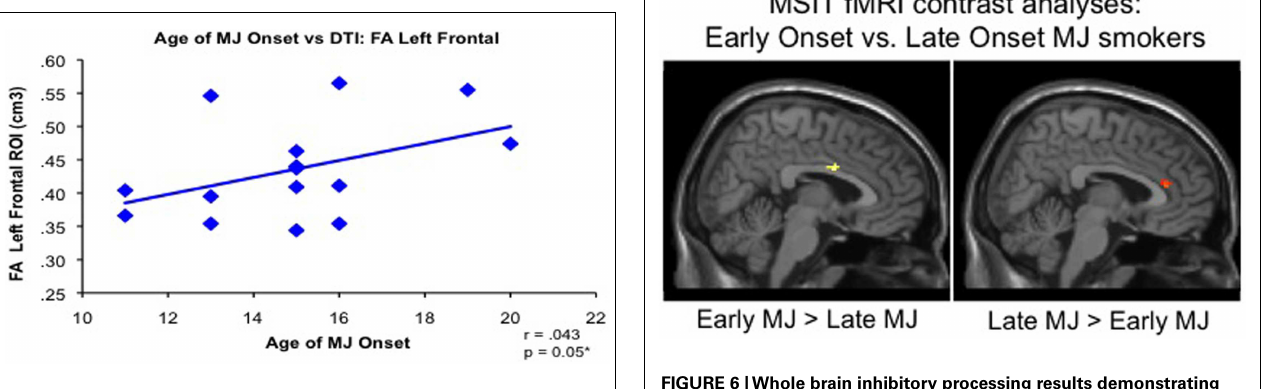
FIGURE 5 | Bivariate relationship between younger age of regular marijuana (MJ) use onset (range 11–20years of age) and decreased white matter integrity (reduced FA measured by diffusion tensor imaging) in 15MJ users in the left frontal region of interest (adapted from Gruber et al., 2011) .